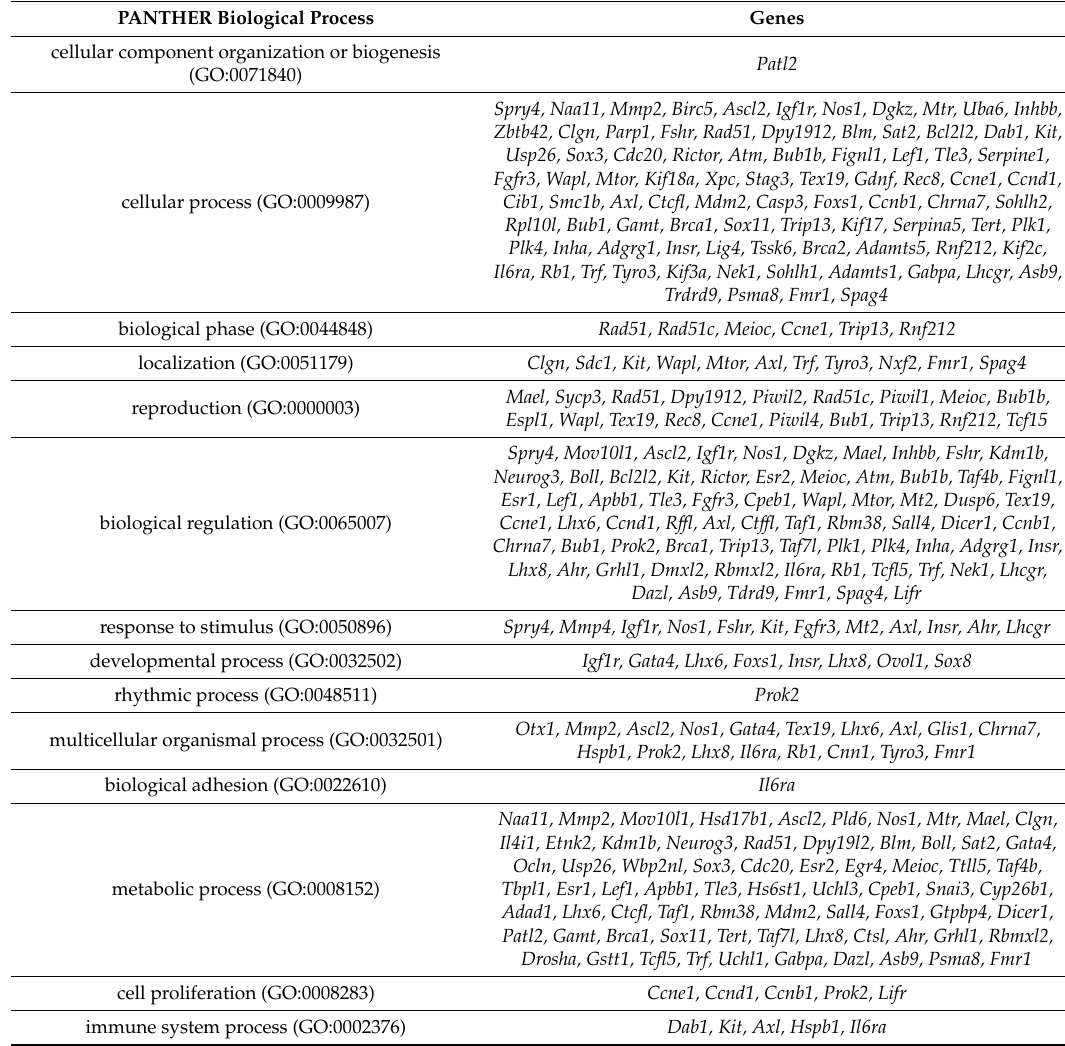
Table 7. PANTHER biological process and corresponding